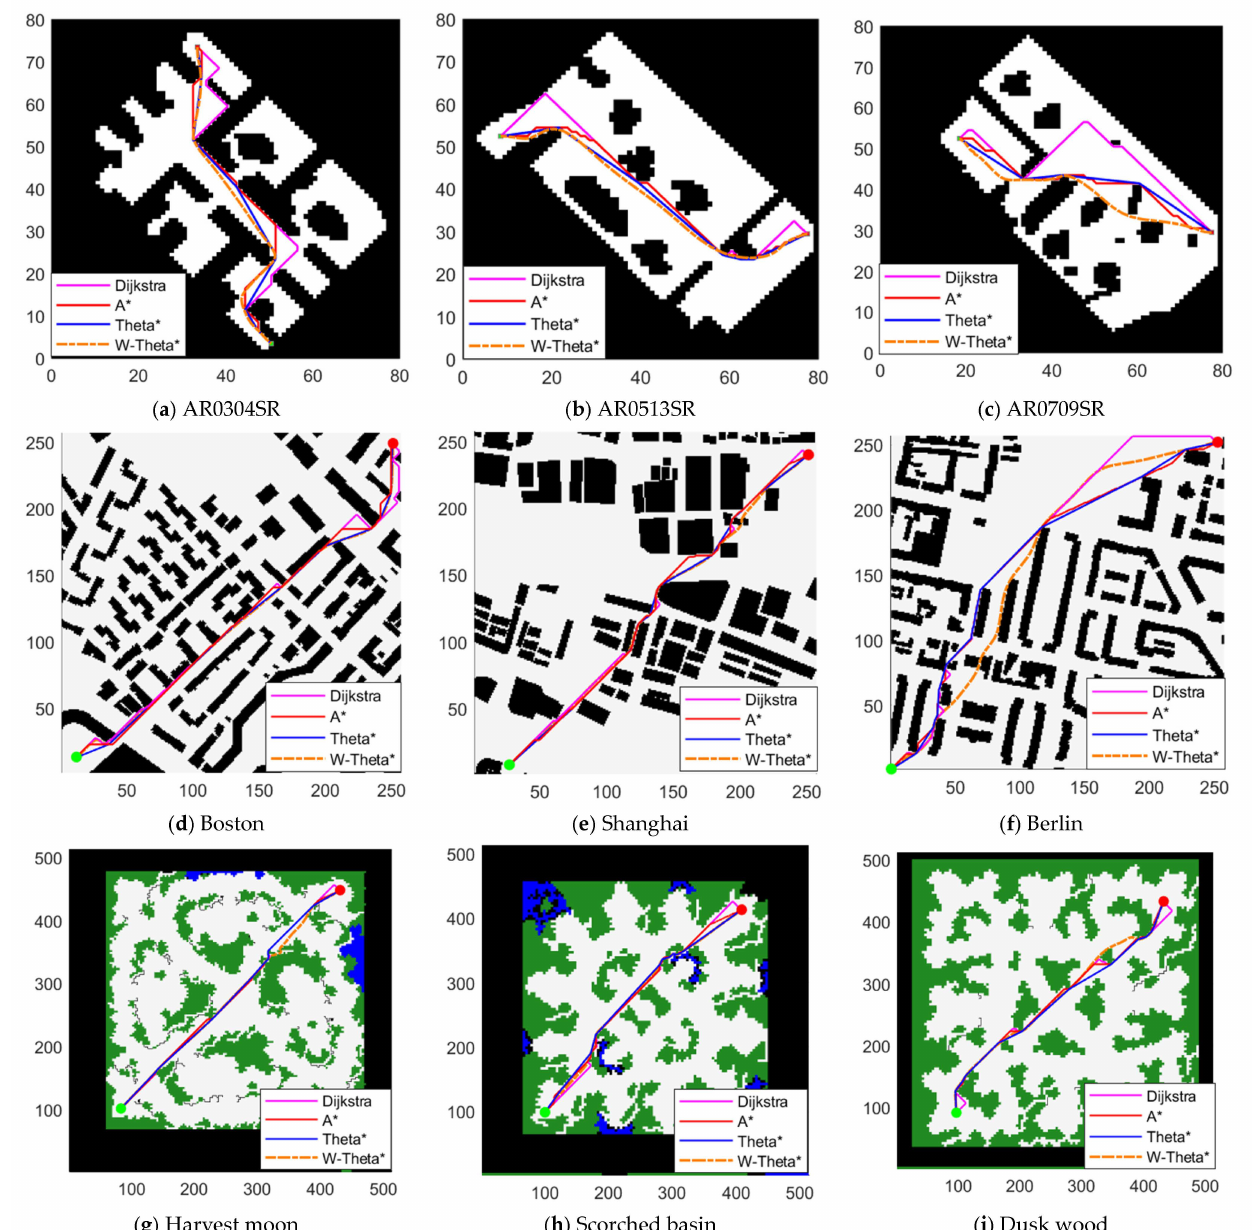
Figure 6. Comparative experimental results of various algorithms on public dataset